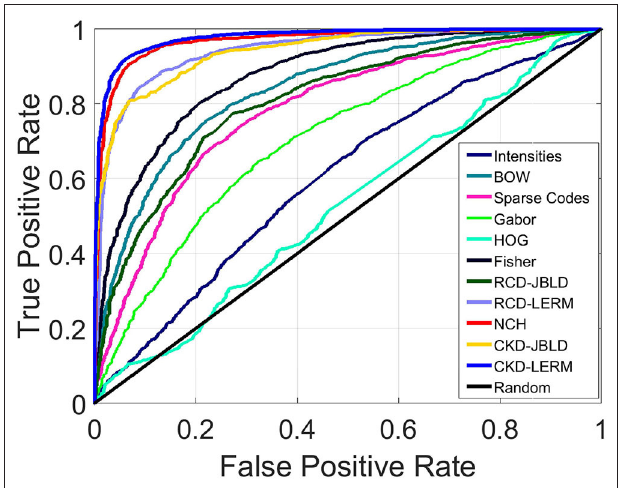
TABLE 2 | Experimental results on FABCD against